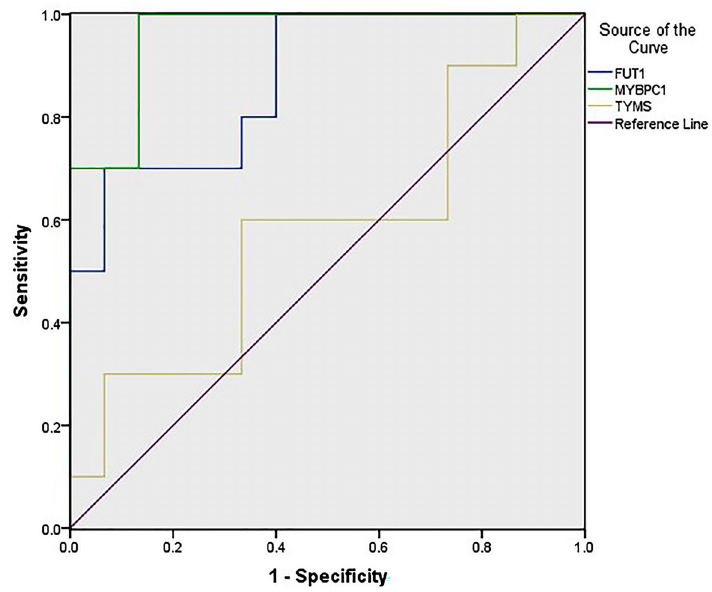
Figure 5. Receiver operating characteristic curve of MYBPC1 and FUT1 as biomarkers for pan- creaticobiliary maljunction (PBM). Area under the curve = 0.960 and 0.873,